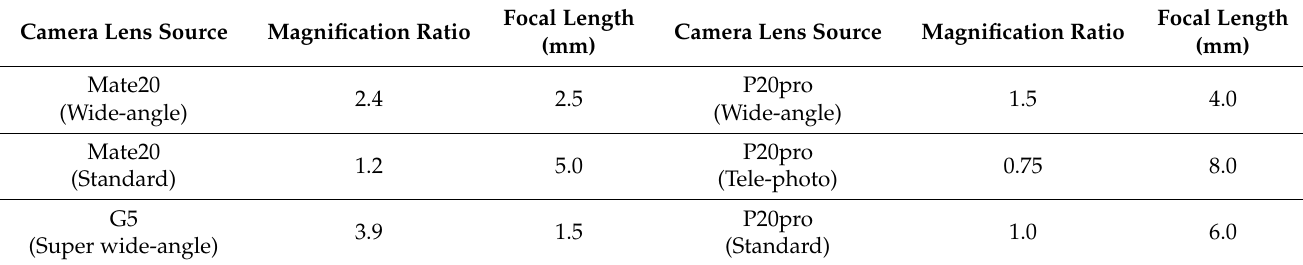
Table 1. Measurement result of magnification ratio and calculated focal length.